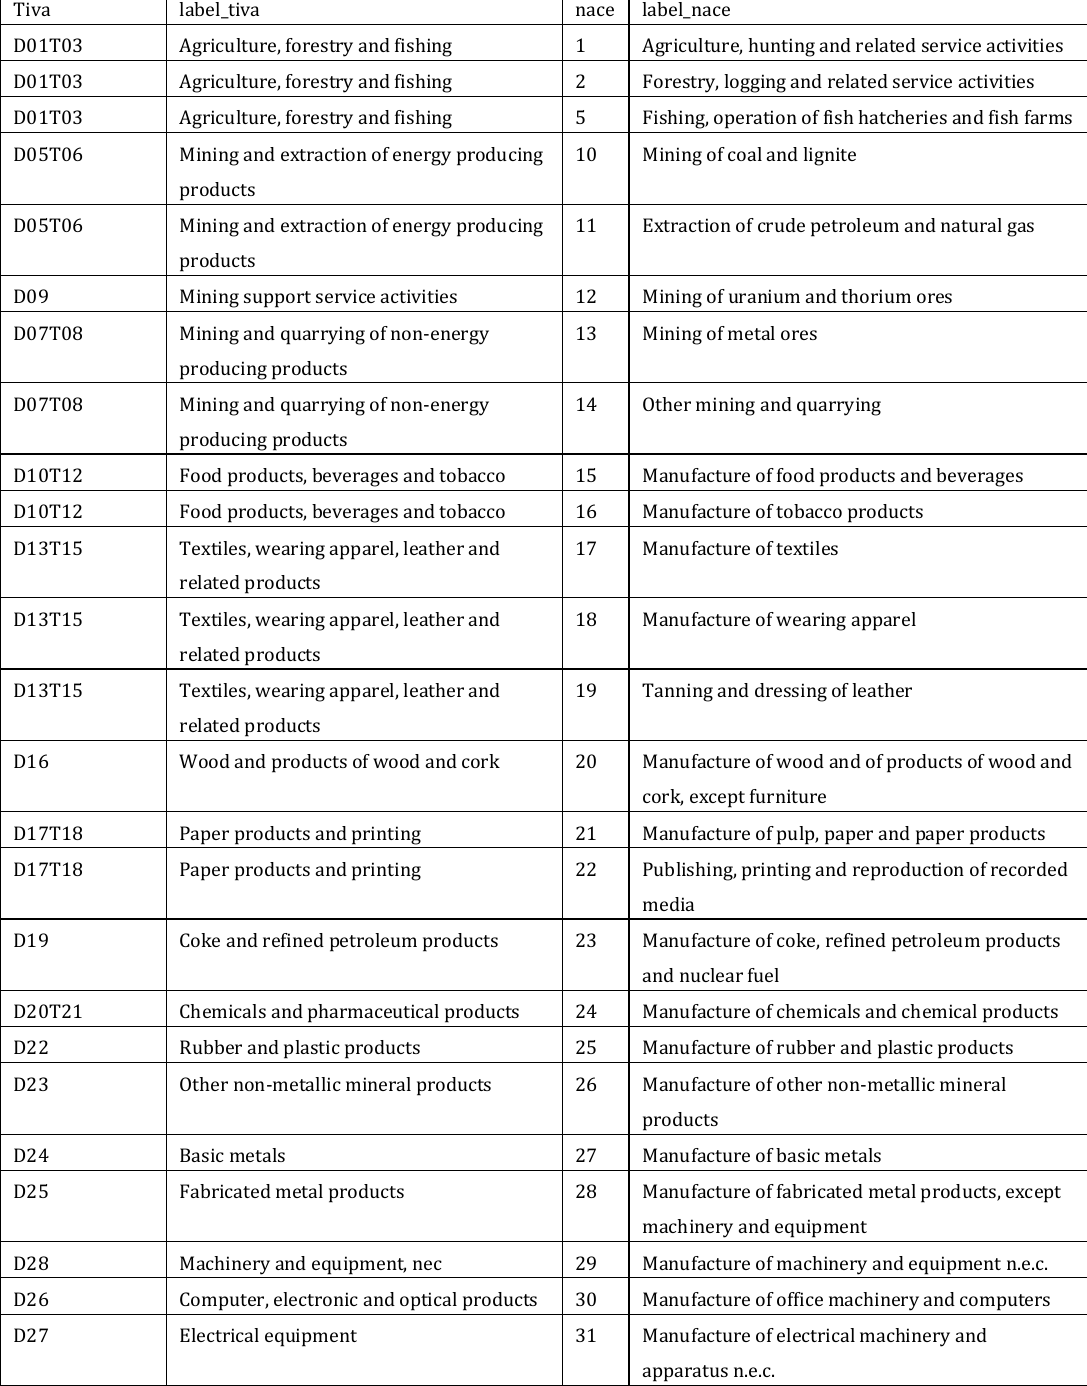
Table A1. Correspondence between NACE and TiVA